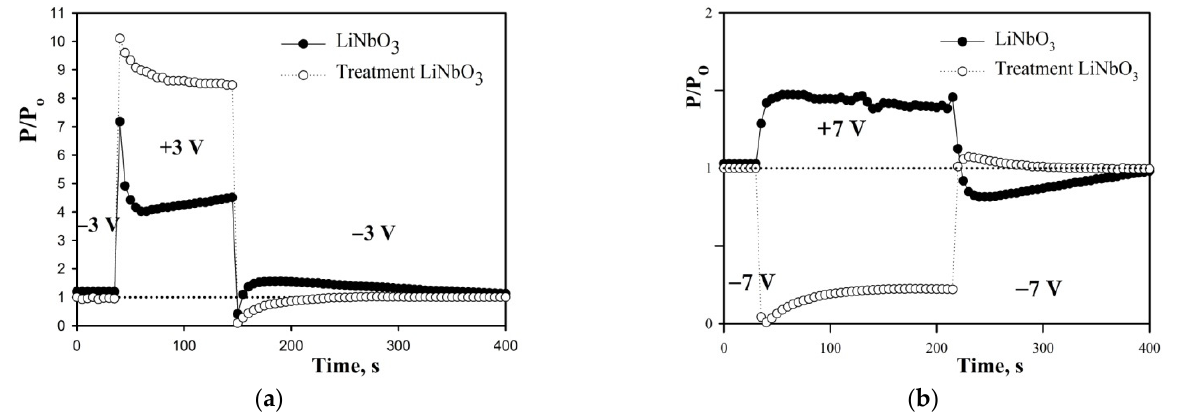
Figure 3. Short-term DC-drift at ±3 ( a ) and ±7 V ( b ).